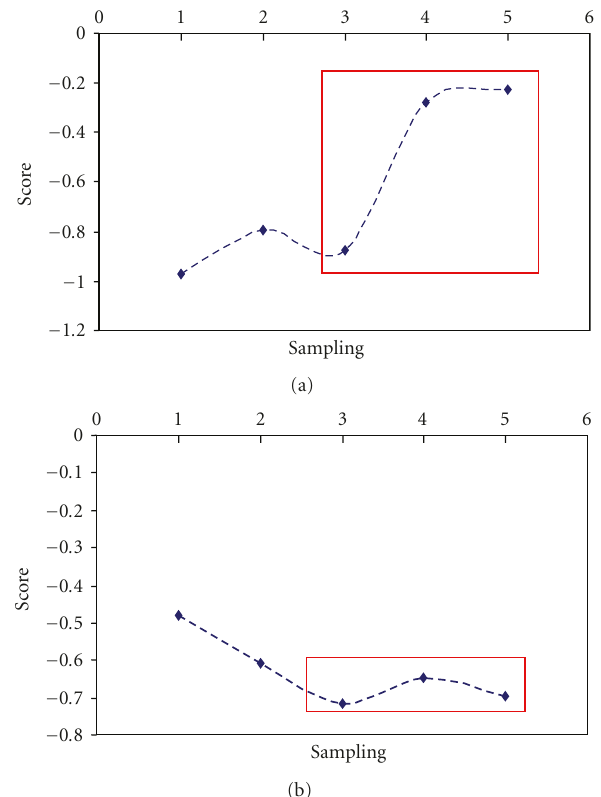
Figure 26: NPA sequence, A S versus s n . (a) g = 0 case, Max Numbers = 3, (b) g = 1 case, Max Numbers =